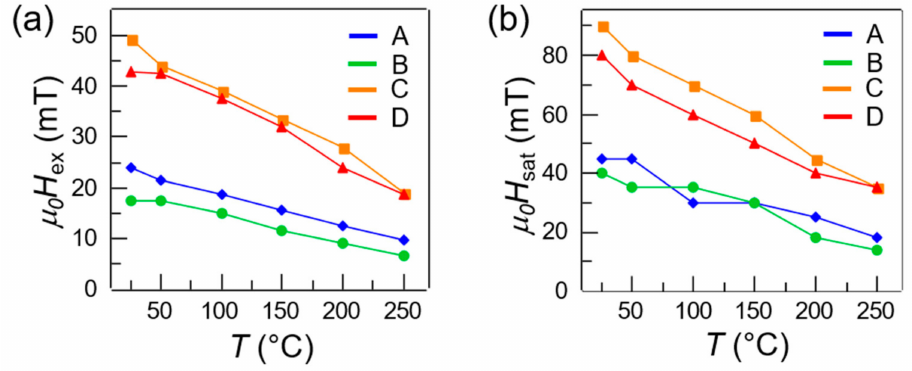
Figure 4. ( a , b ) Exchange field µ 0 H ex and saturation field µ 0 H sat as a function of temperature for sets A–D